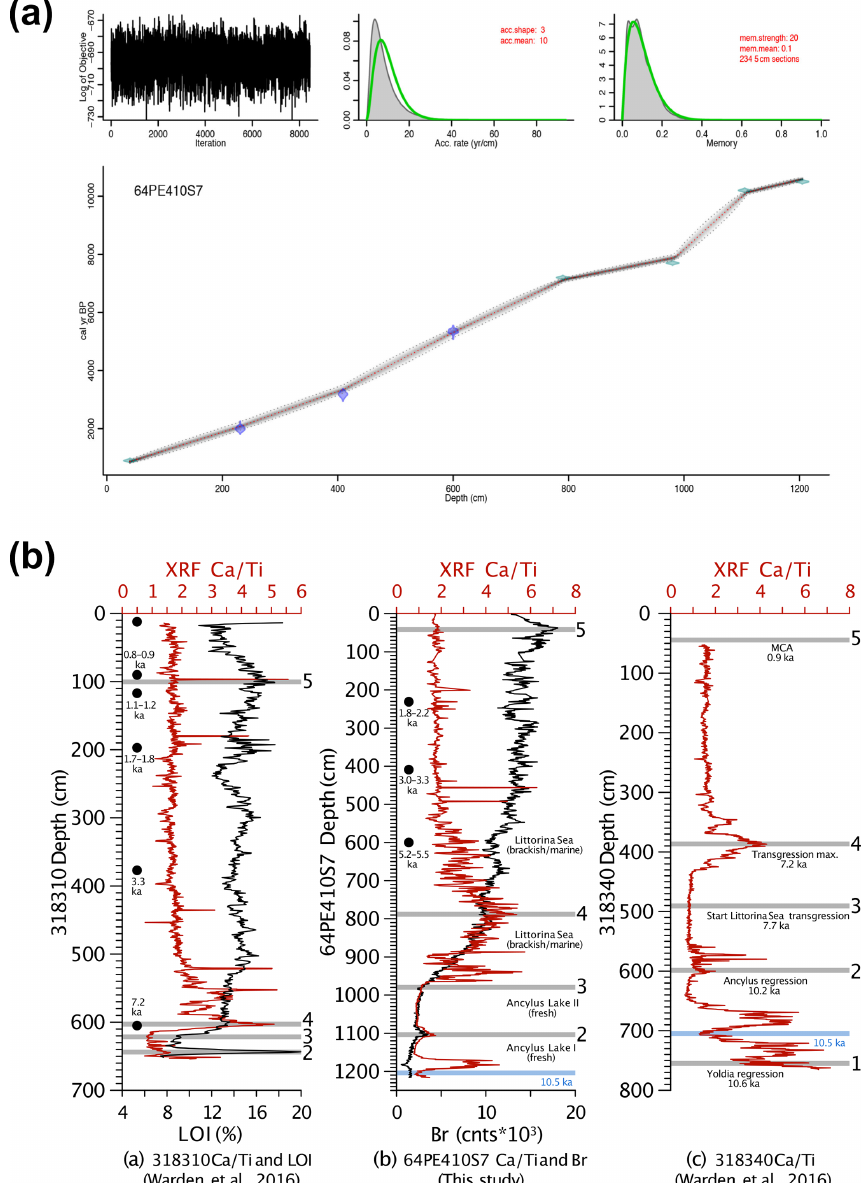
Figure 2. (a) The age–depth model generated by the Bacon R package in R (Blaauw and Christen, 2011). (b) Correlation between core 64PE410-S7 and nearby cores from Warden et al. (2016) using XRF Ca / Ti ratios and Br counts. Black dots represent 14 C dates. Five tie points between the three cores are shown by the grey lines and are as follows: (1) the boundary between the Yoldia Sea and Ancylus Lake at 10.6ka, (2) the Ancylus Lake regression at 10.2ka, (3) the start of the marine transgression between the Ancylus Lake and Littorina Sea phases, (4) the transgression maximum at 7.2ka, and (5) the Medieval Climate Anomaly at 0.9ka. A minimum Ca / Ti ratio between both 64PE410-S7 and 318340 serves as an additional tie point between these two cores and is denoted by the blue line at 10.5ka.